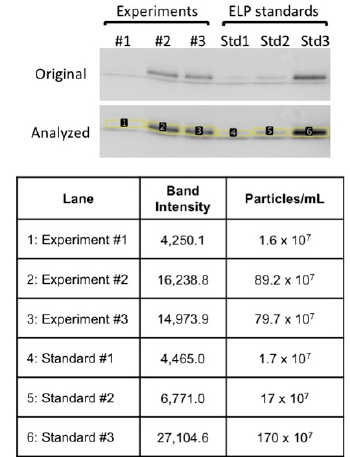
Figure A2. Western blot-based densitometric analysis for residual LP-A96 in purified EV samples. Purified EVs from three independent experiments (Experiments #1~3, lane 1~3) were blotted for ELPs using anti-ELP antibody AK1 [30] to detect and quantify residual LP-A96 co-purified with exosomes. To determine this, firstly, particle concentration of pure LP-A96 was determined (particle number/mL) using nanoparticle tracking analyzer. Secondly, serial dilutions of LP-A96 were prepared and their particle concentration was correlated to the band intensity in Western blot (ELP Standard #1~3, lane 4~6). Lastly, the standard curve generated based on this correlation was used to extrapolate the LP-A96 particle amount co-purified in EV samples after LP-A96 treatment (lane 1~3). This calculation was used to reflect the raw increase in exosomes in Figure 3B.